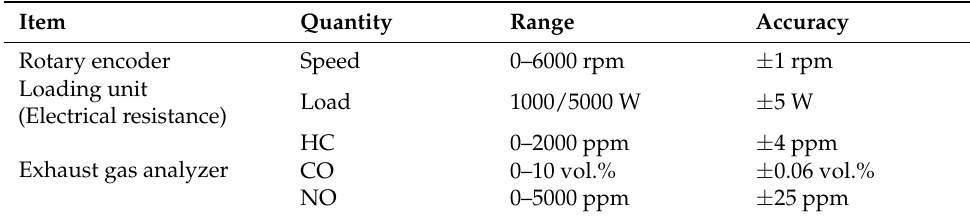
Table 3. The measurement ranges and resolutions of the quantities.